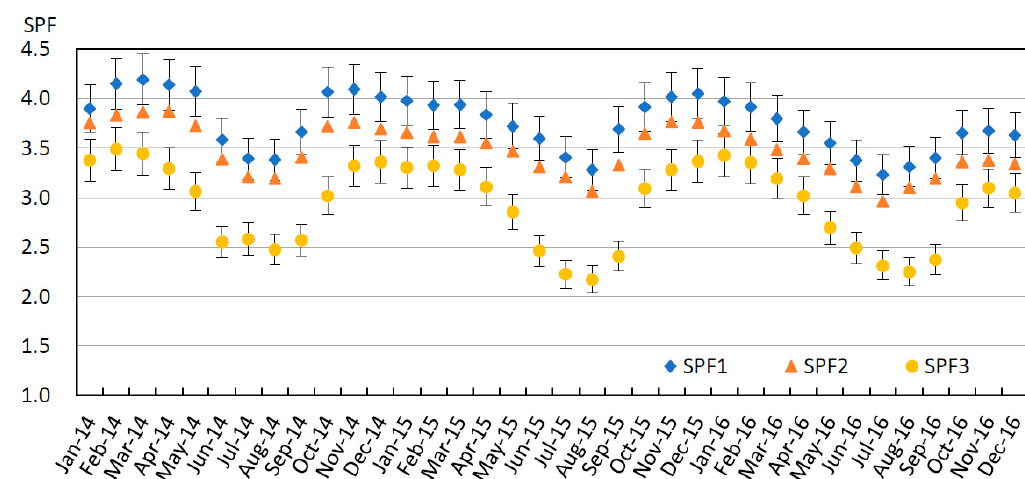
Figure 21. Monthly SPF 1 , SPF 2 , and SPF 3 values based on Annex 52 boundaries.